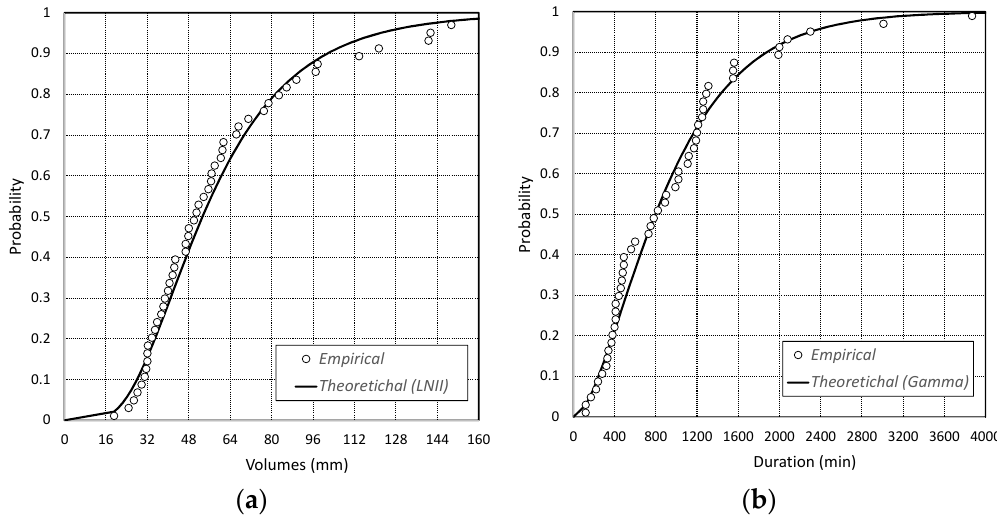
Figure 8. Goodness of fit assessment of marginal distribution of: ( a ) rainfall volumes; ( b ) durations. Temporal patterns of rainfall (event profile), for each event, were characterized using the mass curves concept, and the dimensionless hyetographs so derived for the selected annual maximum rainfall events (Figure 9a) have been used for the derivation of synthetic rainfall.